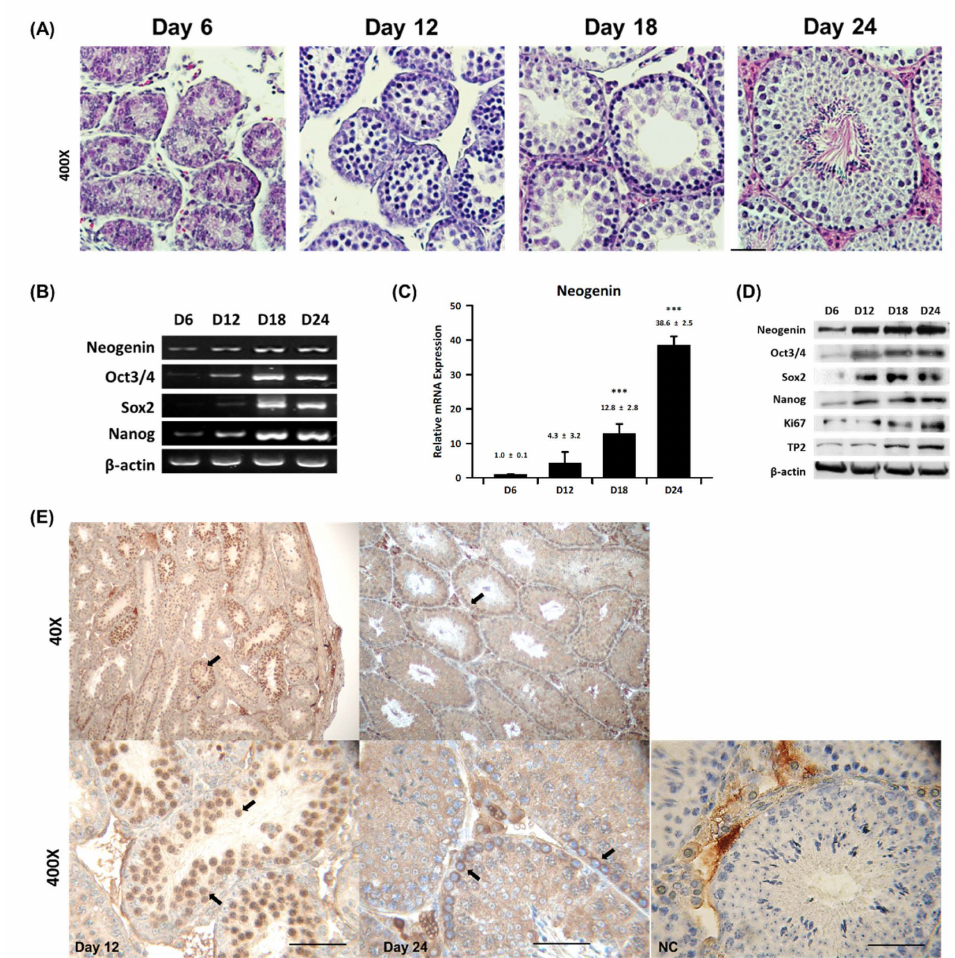
Figure 1. Expression profile of neogenin in the mouse testis. ( A ) Testes obtained from mice at postnatal day 6–24 were cross-sectioned, stained with hematoxylin and eosin, and viewed under a microscope. Scale bar = 100 mm. ( B ) mRNA was extracted from testicular tissues, subjected to RT-PCR to amplify mRNAs encoding neogenin, Oct3/4, Sox2, and Nanog, and resolved on an agarose gel. ( C ) qPCR data of neogenin depend on the postnatal days. (n = 3) ( D ) Proteins were extracted from testicular tissues and analyzed by Western blotting using antibodies against neogenin, Oct3/4, Sox2, Nanog, Ki67, and TP2. β -actin was used as a control. ( E ) Seminiferous tubules were cross-sectioned and subjected to immunohistochemical DAB staining for neogenin at postnatal days 12 and 24. NC, negative control. Arrows indicate neogenin-positive cells. Scale bar = 100 mm. *** p <